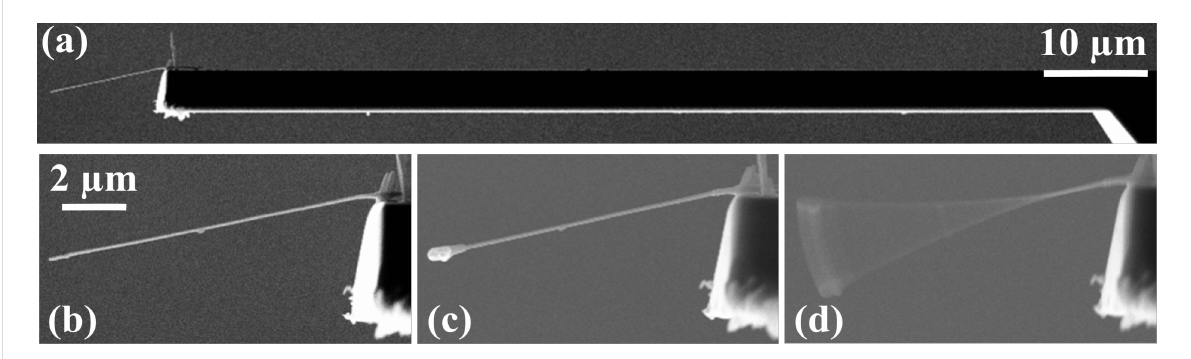
Figure 3: SEM images (a) of the fabricated sensor, (b) and (c) of the free end of the FeCNT before and after carbon deposition and (d) of the co-reso- nant oscillation of the FeCNT.